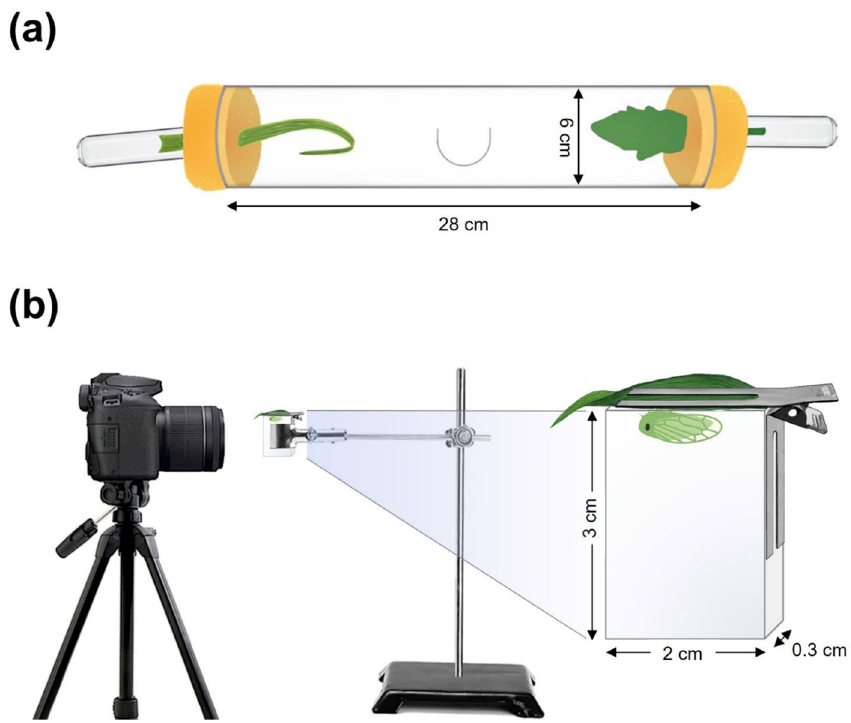
Figure 1. Diagrammatic illustrations of ( a ) feeding and oviposition preference experiments and ( b ) feeding